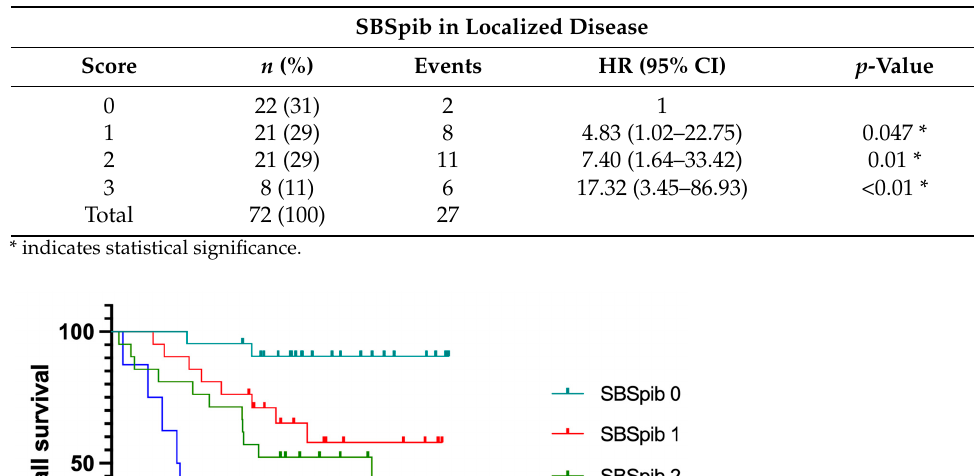
Table 4. Hazard ratios for overall survival in the new model.